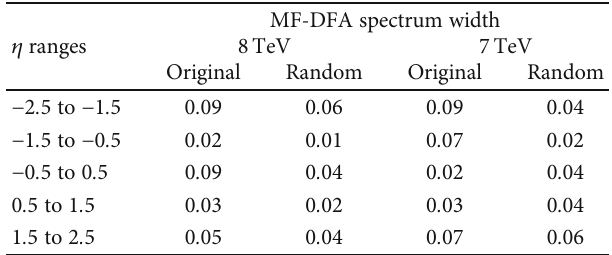
Figure 3: Comparison of the widths of the multifractal spectrum generated η spaces for all the 5 ranges of η values for 7 and 8TeV datasets. Table 1: Comparison of the widths of the multifractal spectrum generated η spaces for all the 5 ranges of η values for 7 and 8 TeV datasets, between the original and the randomized